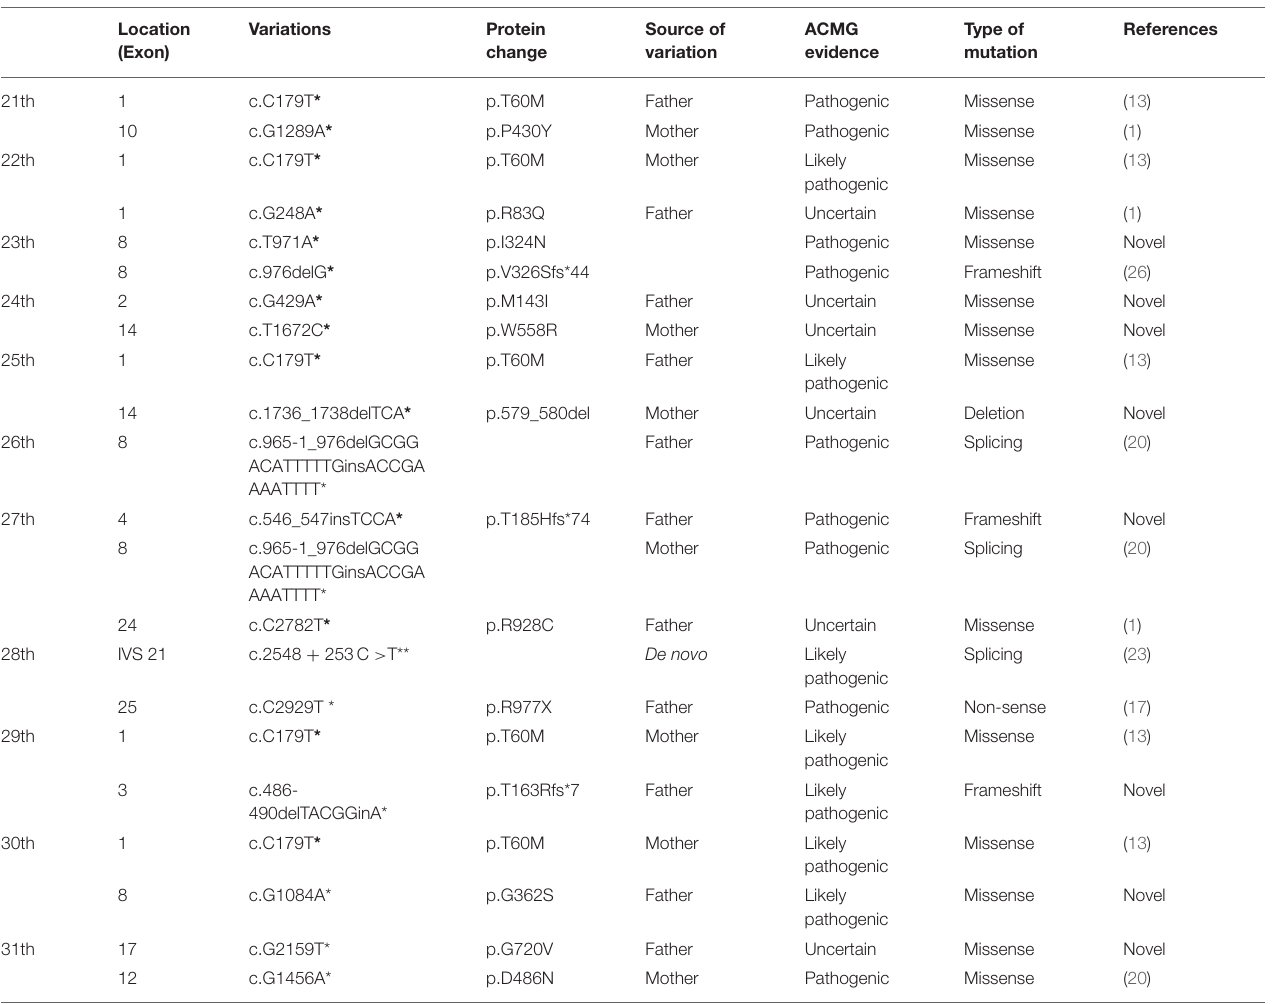
compound heterozygous mutations (24/31, 77.4%) ( Table 2 and Figure 1